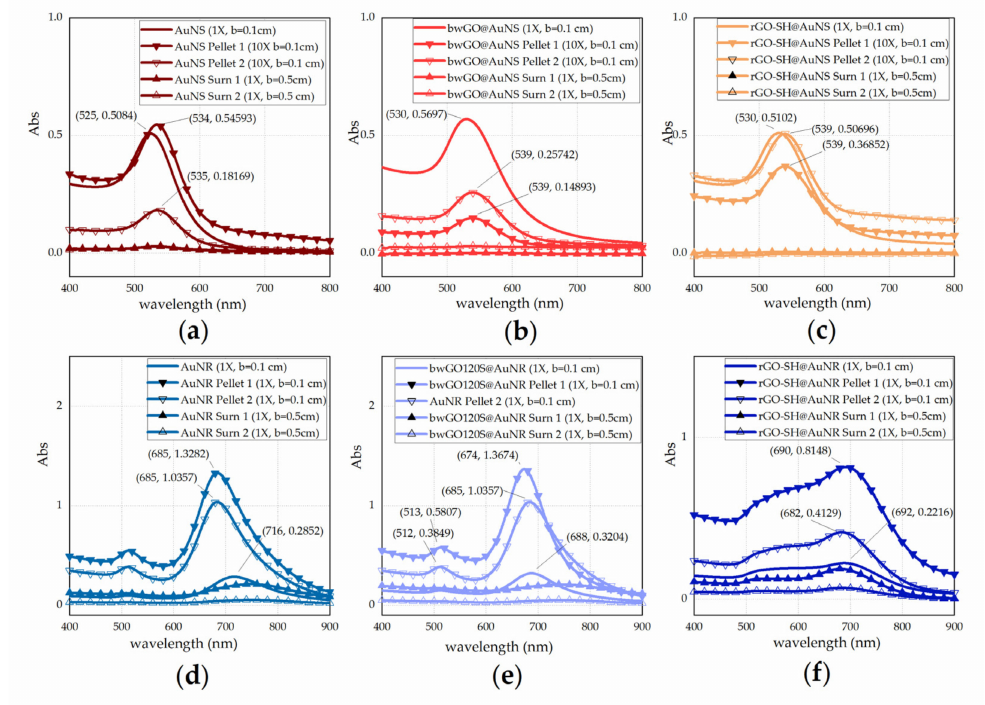
Figure 5. UV-VIS spectra of the di ff erent nanocomposite dispersions, before and after the two centrifugation steps for ( a ) AuNS (wine), ( b ) bwGO@AuNS (red), ( c ) rGOSH@AuNS (orange), ( d ) AuNR (cyan), ( e ) bwGO@AuNR (light blue), ( f ) rGOSH@AuNR